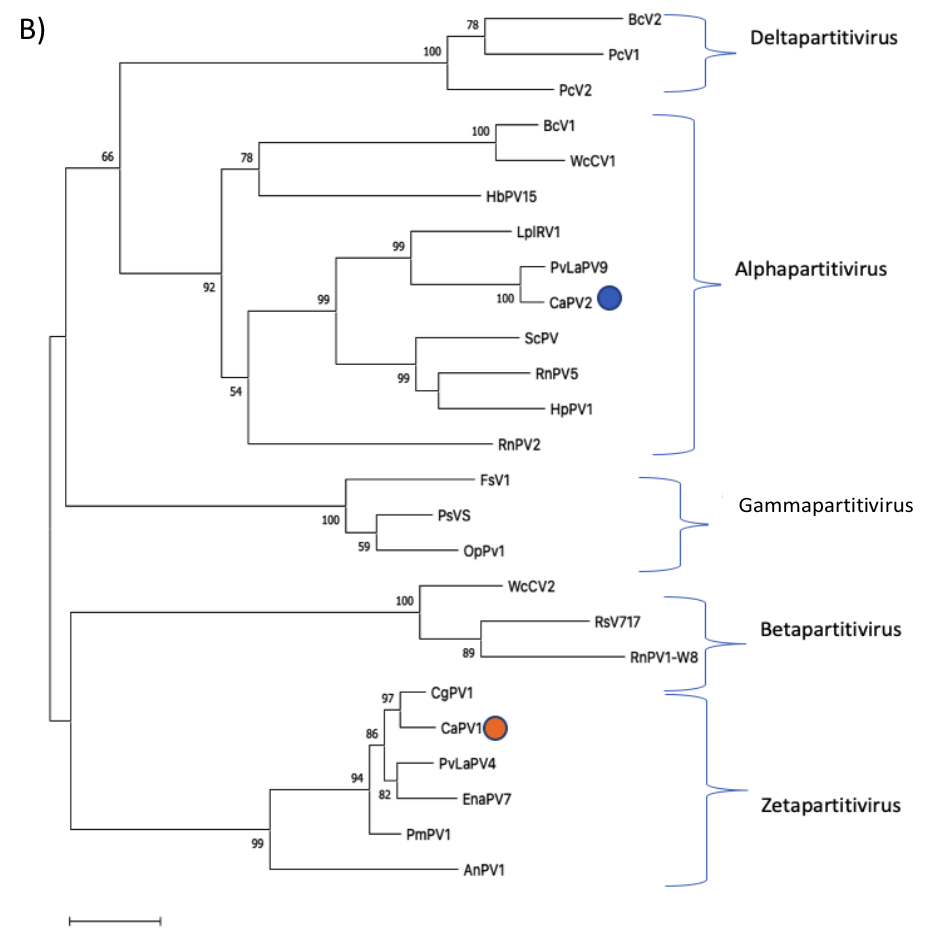
Figure 3. Phylogenetic analyses of RdRps ( A ) and CPs ( B ) of CaPV1, CaPV2 and related partiti- viruses using the function “build” of ETE3 3.1.2 [39] as implemented on the GenomeNet (https://www.genome.jp/tools/ete/, accessed on 2 September 2022). Alignment was performed with MAFFT v6.861b with the default options [40]. ML tree was inferred using IQ-TREE 1.5.5 ran with ModelFinder and tree reconstruction [41]. Best-fit models, according to BIC, were VT+F+R5 and VT+F+I+G4 for RdRp and CP phylogenetic trees, respectively. Tree branches were tested by SH-like aLRT with 1000 replicates. Different members of the partiti-virus genera, including Alpha-, Beta-, Delta-, Gamma- and the proposed Epsilonpartitivirus were included in the analyses. Viruses found in this study were marked with a circle. Bootstrap values are indicated at the branches. The scale bar (lower left) represents the genetic distance of 0.50 for the phylogenetic tree of partitiviral RdRps